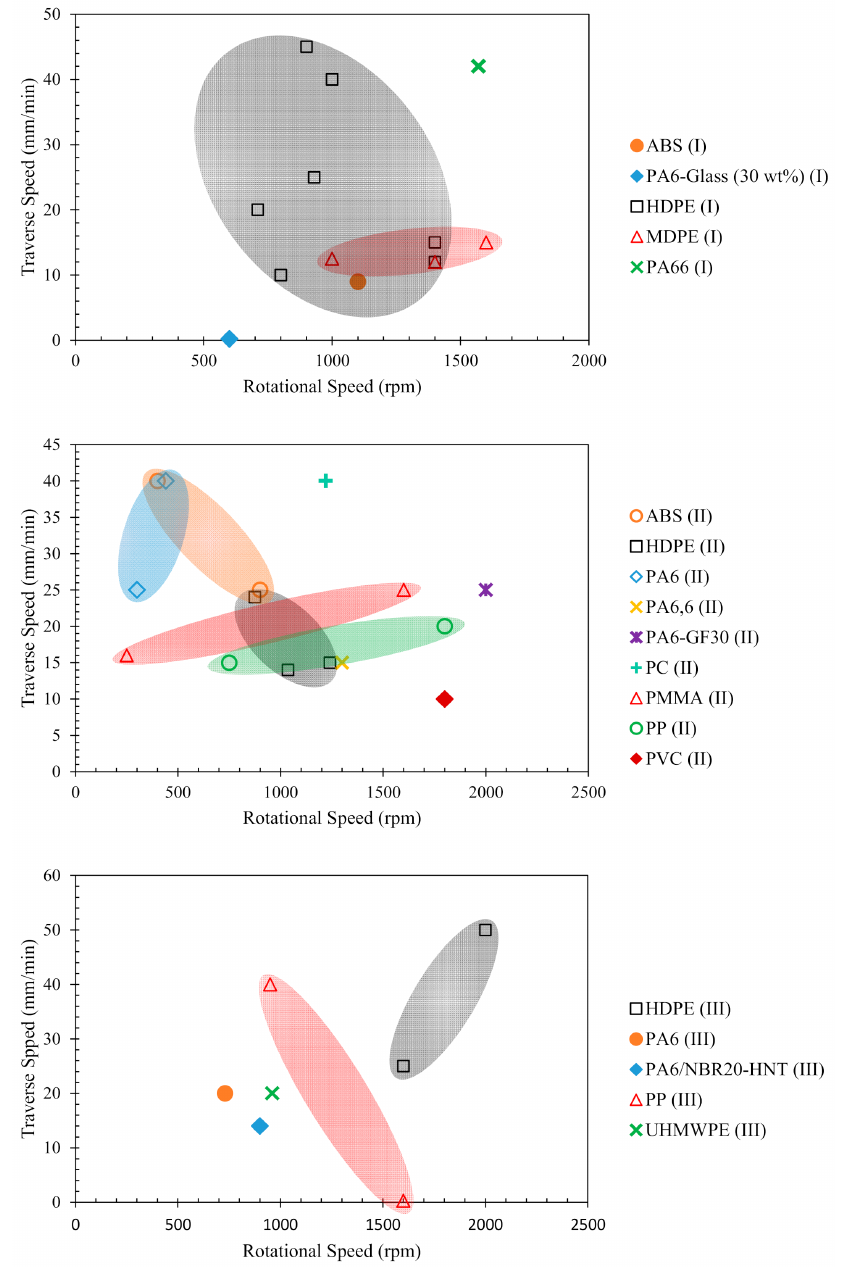
Figure 3. Optimal rotational and traverse speeds for achieving maximum joint tensile strength for FSW of thermoplastic sheets in butt-joint configuration. I denotes FSW (single- and double-side) using cylindrical pin profile, II denotes FSW with other than cylindrical pin profile, and III denotes heat-assisted